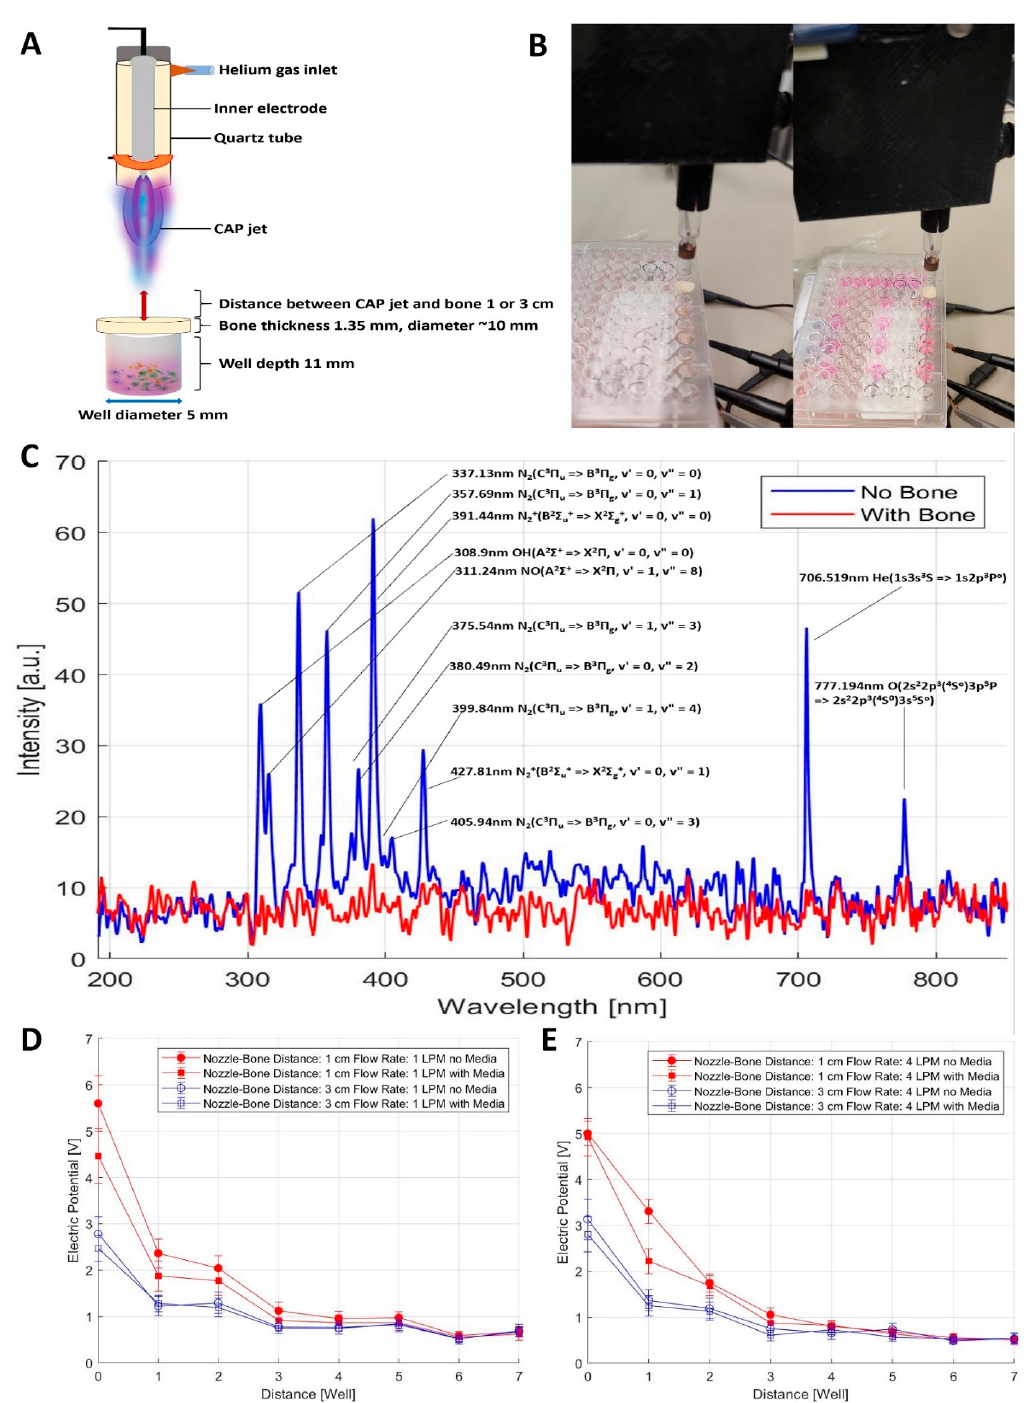
Figure 4. ( A ) Schematic illustration of the experimental setup for the measurement of OES and EM emission through human fibula bone. ( B ) Images of treatment and measurement without media (left) and with the media (right). ( C ) OES measurements of the CAP jet with (red) and without (blue) the bone. EM wave emission measurements at 1 LPM ( D ) and 4 LPM ( E ). The distance between the plume and bone were 1 cm (labeled as red) and 3 cm (blue). The well labeled as ‘0’ indicates the well that was targeted with CAP through the bone. n =